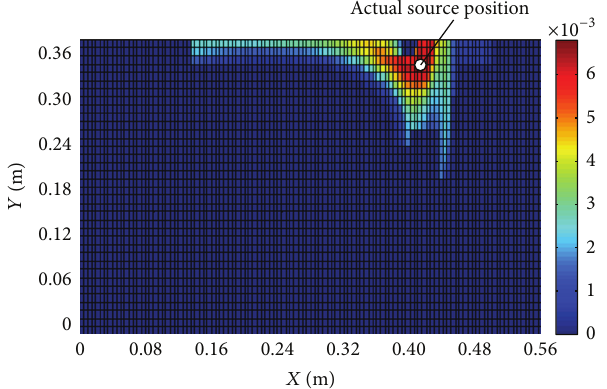
Figure 9: Distribution map of location probability for the experi- mental